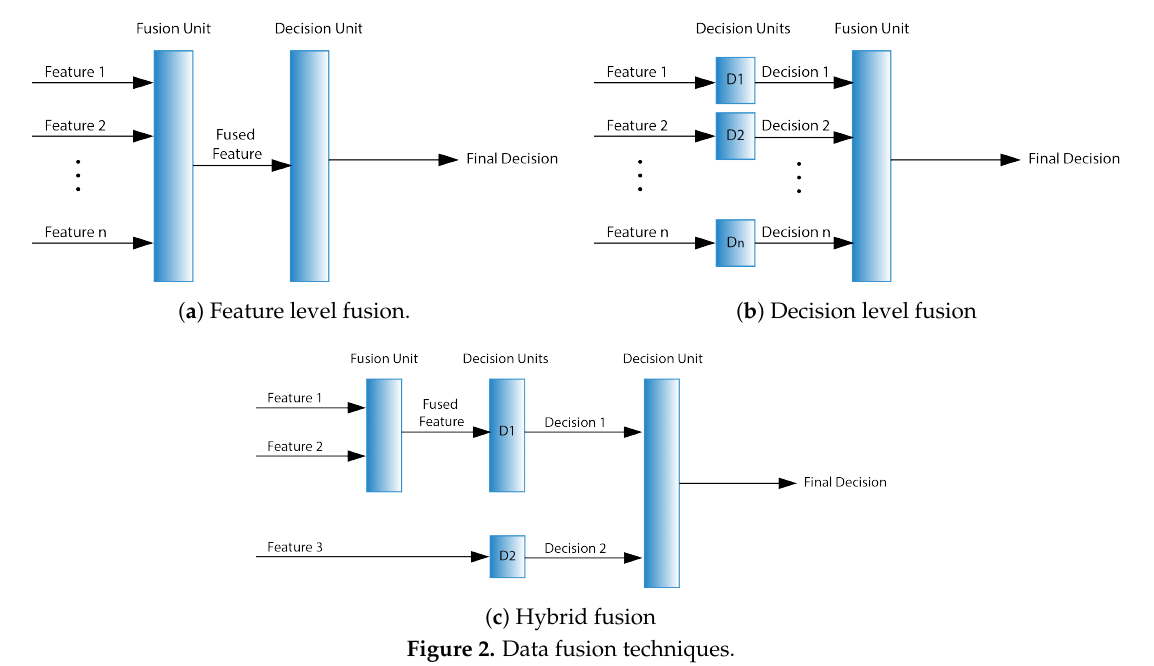
Figure 2. Data fusion